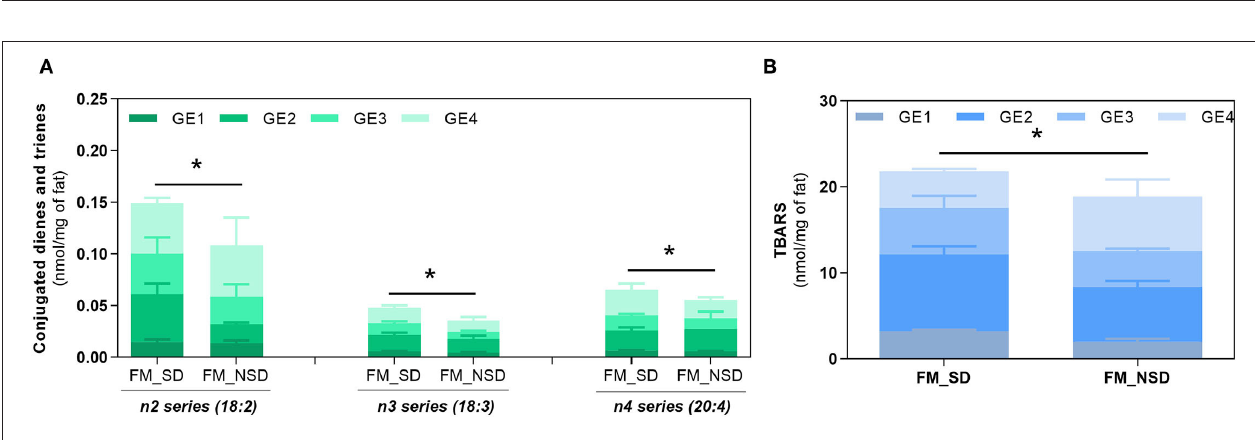
FA profile of BM ( ω 3 < ω 6 = SFA < MUFA) differed from